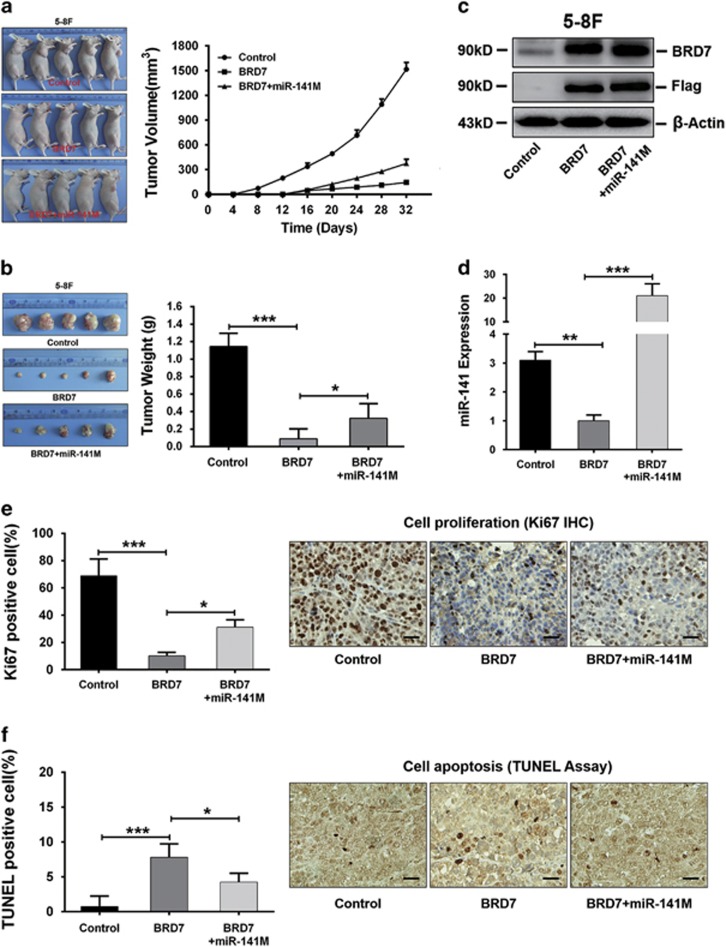
BRD7 inhibited tumor growth by downregulating miR-141 expression in vivo. (a) Images (left panel) and tumor growth curve (right panel) of the 5-8 F xenograft model in nude mice. (b) Tumor images (left panel) and weight quantification (right panel) (N=5). (c) Western blot and (d) qRT-PCR assay confirmed the expression of the BRD7 protein and of mature miR-141 in xenograft tumor tissues, respectively. β-Actin and U6 served as internal controls, respectively. (e) IHC (DAB staining) for quantification of the proliferation marker Ki-67 (left panel) and images (right panel) and (f) TUNEL (DAB staining) for quantification of apoptosis (left panel) and images (right panel). Three tumors were analyzed per group using immunohistochemistry for the molecules mentioned above. (e and f) Original magnification, × 200; the size bars represent 25 μm. (b, d, e and f) The error bars are presented as the mean±S.E.M. Control: Vector+miR-NC, BRD7: BRD7+miR-NC. *P<0.05, **P<0.01, ***P<0.001